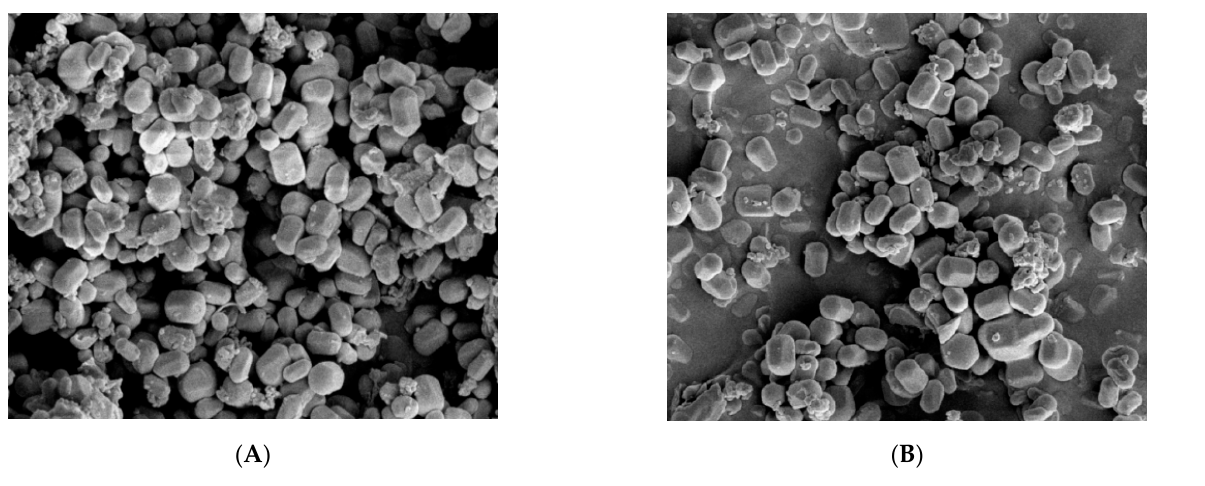
Figure 10. SEM images of MCM-41 ( A ) and NH 2 -MCM-41 ( B ).